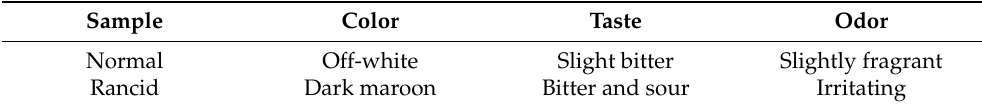
Table 1. The traditional sensory properties of normal and rancid ZSS samples. Sample Color Taste Odor Normal Off-white Slight bitter Slightly fragrant Rancid Dark maroon Bitter and sour Irritating